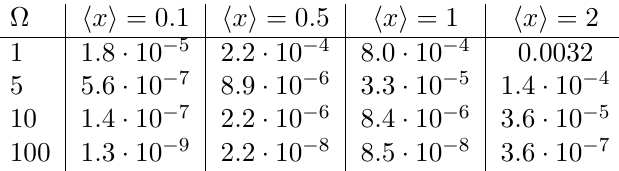
TABLE IV: Sum of squares from